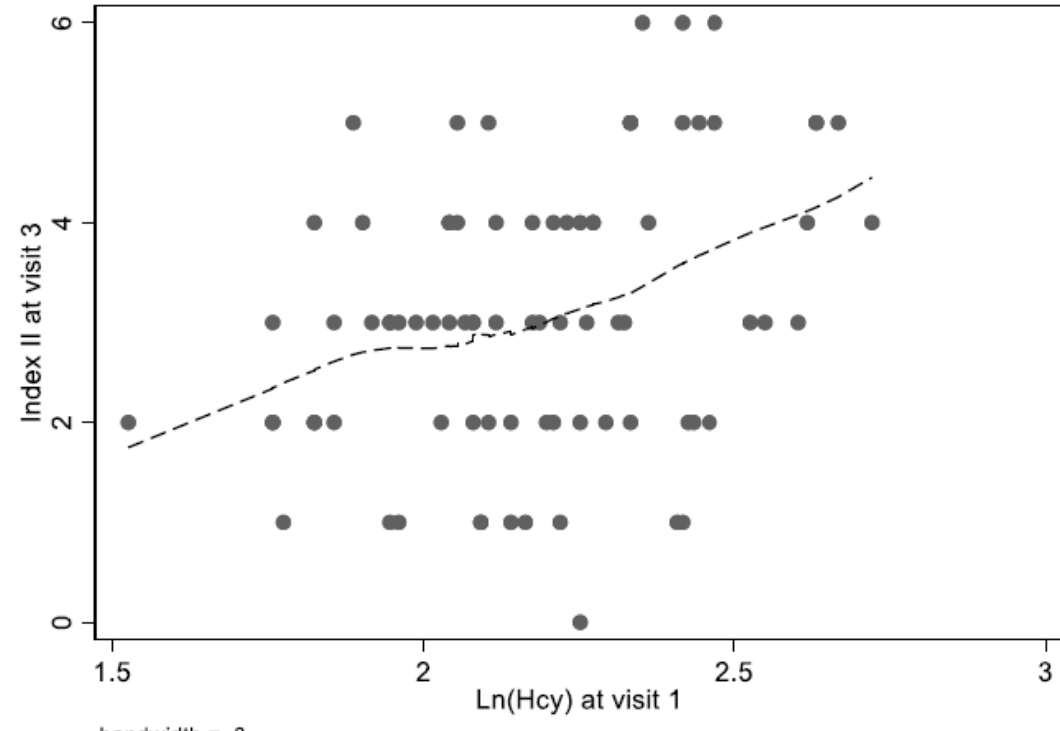
Figure 4. Lowess smoother of total Visit 1 homocysteine vs. Visit 3 Index II ( r = 0.34, n = 81): HANDLS 2004–2009 (Hcy) and 2013–2018 (Index II) 1 . Abbreviations: HANDLS = Healthy Aging in Neighborhoods of Diversity Across the Life Span: Hcy = Homocysteine; NHANES = National Health and Nutrition Examination Surveys; ROC = Receiver Operating Characteristics analysis. 1 Blood total Hcy, in µ mol / L, is Log e -transformed and uncategorized. Index II was computed using cut-points obtained from the pooled NHANES ROC analysis. See Table 2 footnotes for details. Index II may range from 0 to 8, and no cut-point was used in this analysis.